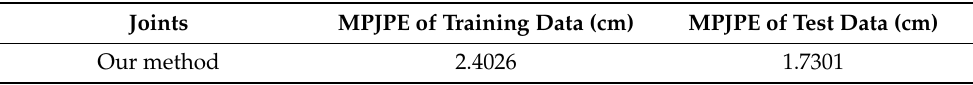
Table 4. Mean per joint position error (MPJPE) values for our